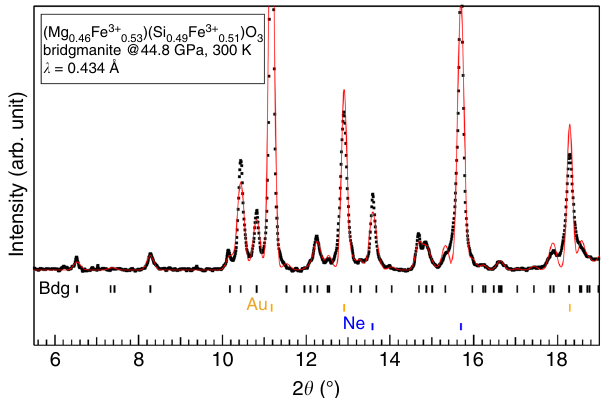
Fig. 1 Full-pro fi le Le Bail re fi nement con fi rms transformation of akimotoite to bridgmanite (Bdg) structure. Measured XRD data for (Mg 0.46 Fe 3 + 0.53 ) (Si 0.49 Fe 3 + 0.51 )O 3 composition at 44.8 GPa and 300 K (black dots) are consistent with orthorhombic GdFeO 3 -type Bdg (black ticks below). Le Bail fi t (red curve) also includes expected peak positions for Au calibrant (yellow ticks) and Ne medium (blue